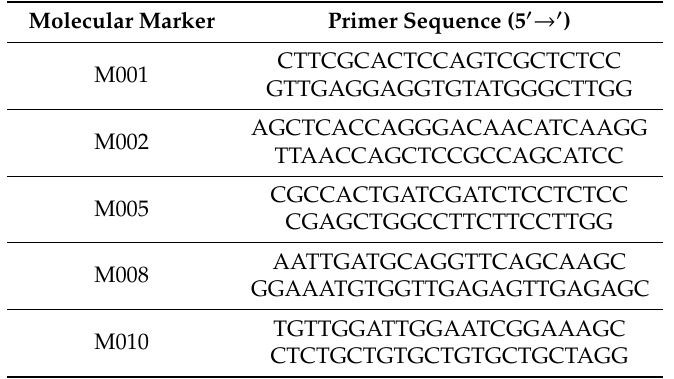
Table 3. The markers developed for the fine mapping of qLTG6 on chromosome 6.